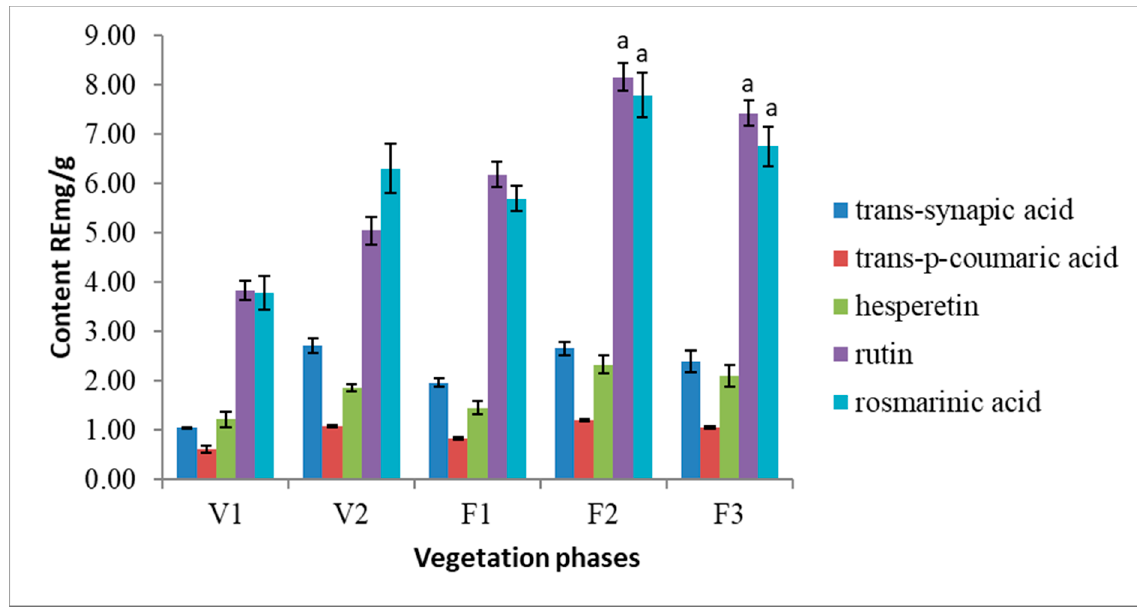
Figure 3. Variation of the main phenolic compounds in Satureja hortensis L. herb samples during vegetation phases determined using high-performance liquid chromatography—DPPH. V1—intensive growth, V2—budding, F1—beginning of flowering, F2—massive flowering, F3—end of flowering. Mean values ± SD from three independent experiments are presented. a statistically significant differences, ( p <